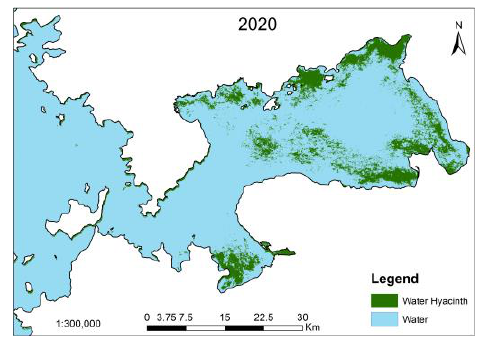
Figure 5: Shows the extent and the coverage location of E. crassipes in Lake Victoria in January of